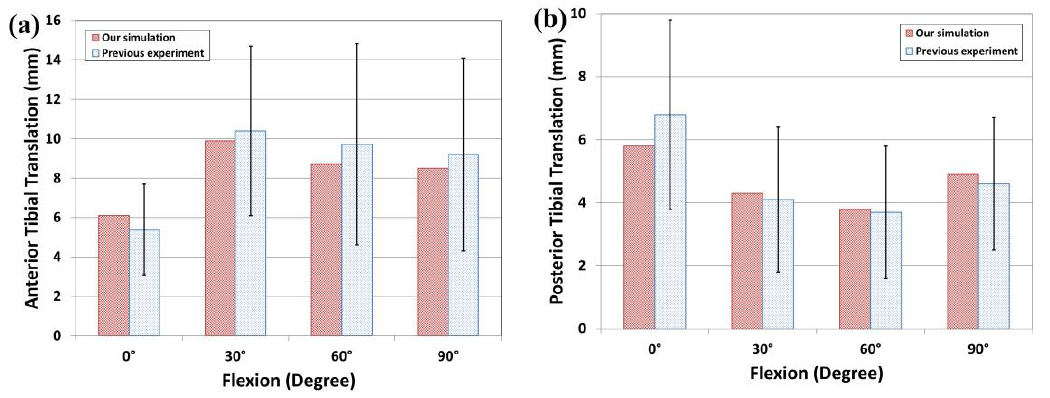
Figure 4. Comparison of validations between the UKA model and a previous experimental study: ( a ) anterior tibial translation; ( b ) posterior tibial translation.